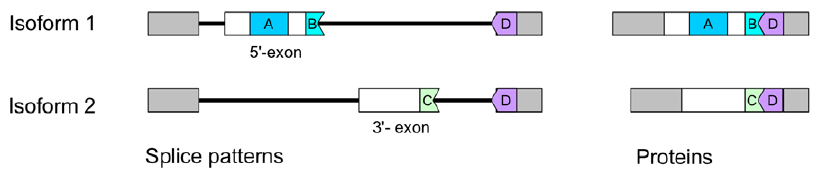
Figure 5. Interaction motif architecture of MADSAFFECTINGFLOWERING1(MAF1) isoforms. Two MADS AFFECTING FLOWERING1 ( MAF1 ) isoforms differ as the result of the selective inclusion of either one of the two mutually exclusive exons (named 5 9 - and 3 9 -exon). Only the 5 9 -exon of the mutually exclusive pair that is included in isoform 1 contains motif A . Both the 5 9 - and 3 9 -exons of the mutually exclusive pair have residues at their 3 9 -boundary that can form interaction motifs ( BD or CD ) together with the first residues of the downstream constitutively spliced exon. Introns are indicated by horizontal lines.